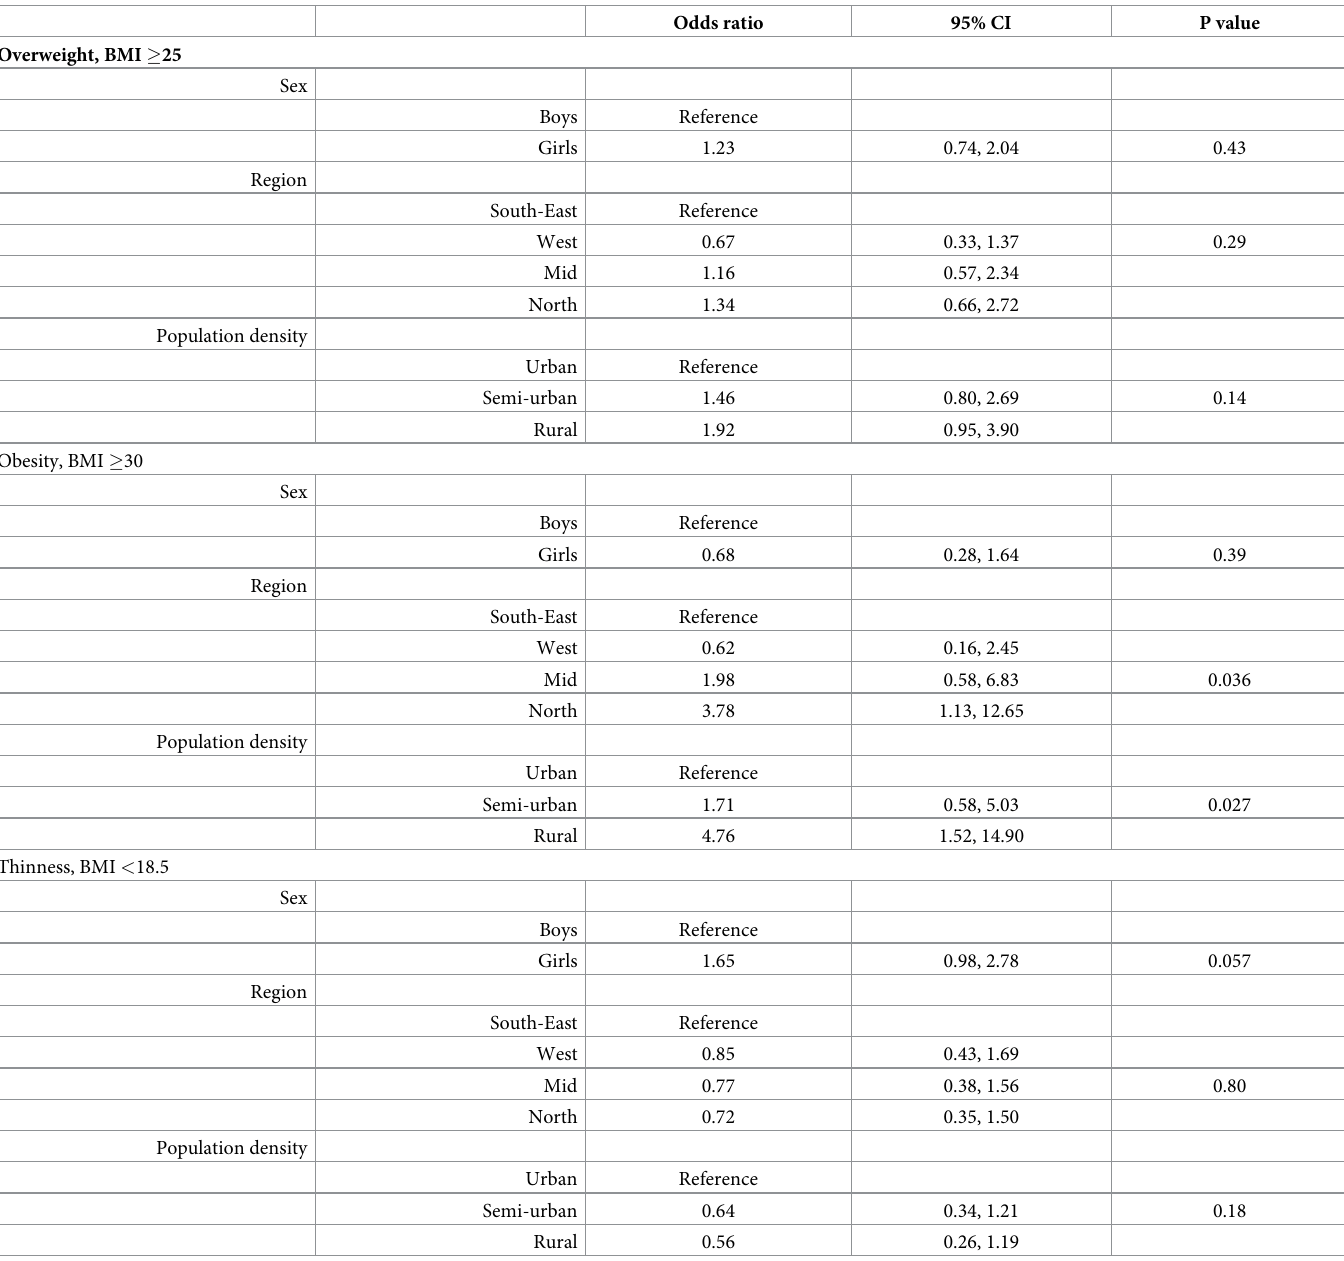
Table 3. Associations � of sex, region, and population density with IOTF † overweight, obesity, and thinness from 8 to 13 years (n = 1852, 3317 observations). Odds ratio 95% CI P